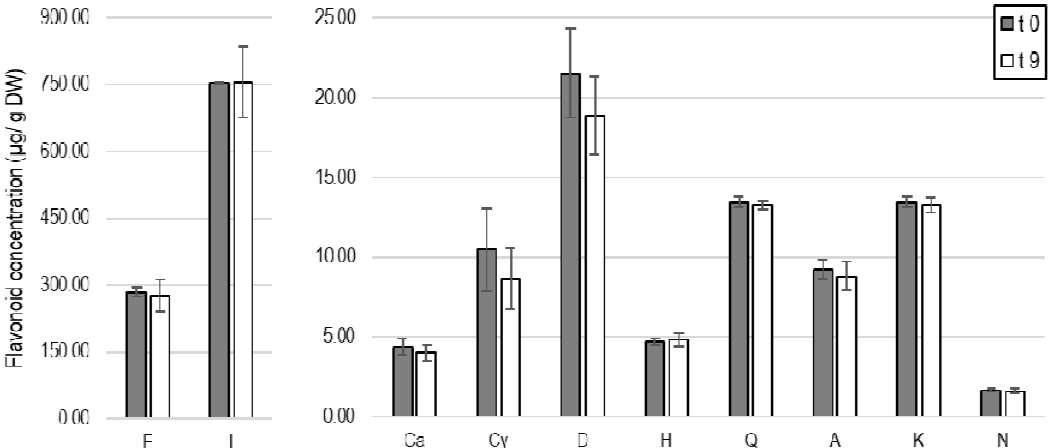
Figure 7. Concentrations ( µ g/g DW) of flavanone (F), isorhamnetin (I), catechin (Ca), cyanidin (Cy), delphinidin (D), hesperidin (H), quercetin (Q), apigenin (A), kaempferol (K), and naringenin (N), quantified by HPLC-UV (280 nm) analysis of ethanolic fractions extracted from Tuxtepec biomass after a few days of storage (t 0) and nine-month storage (t 9), preventing oxygen, moisture, and light exposure.